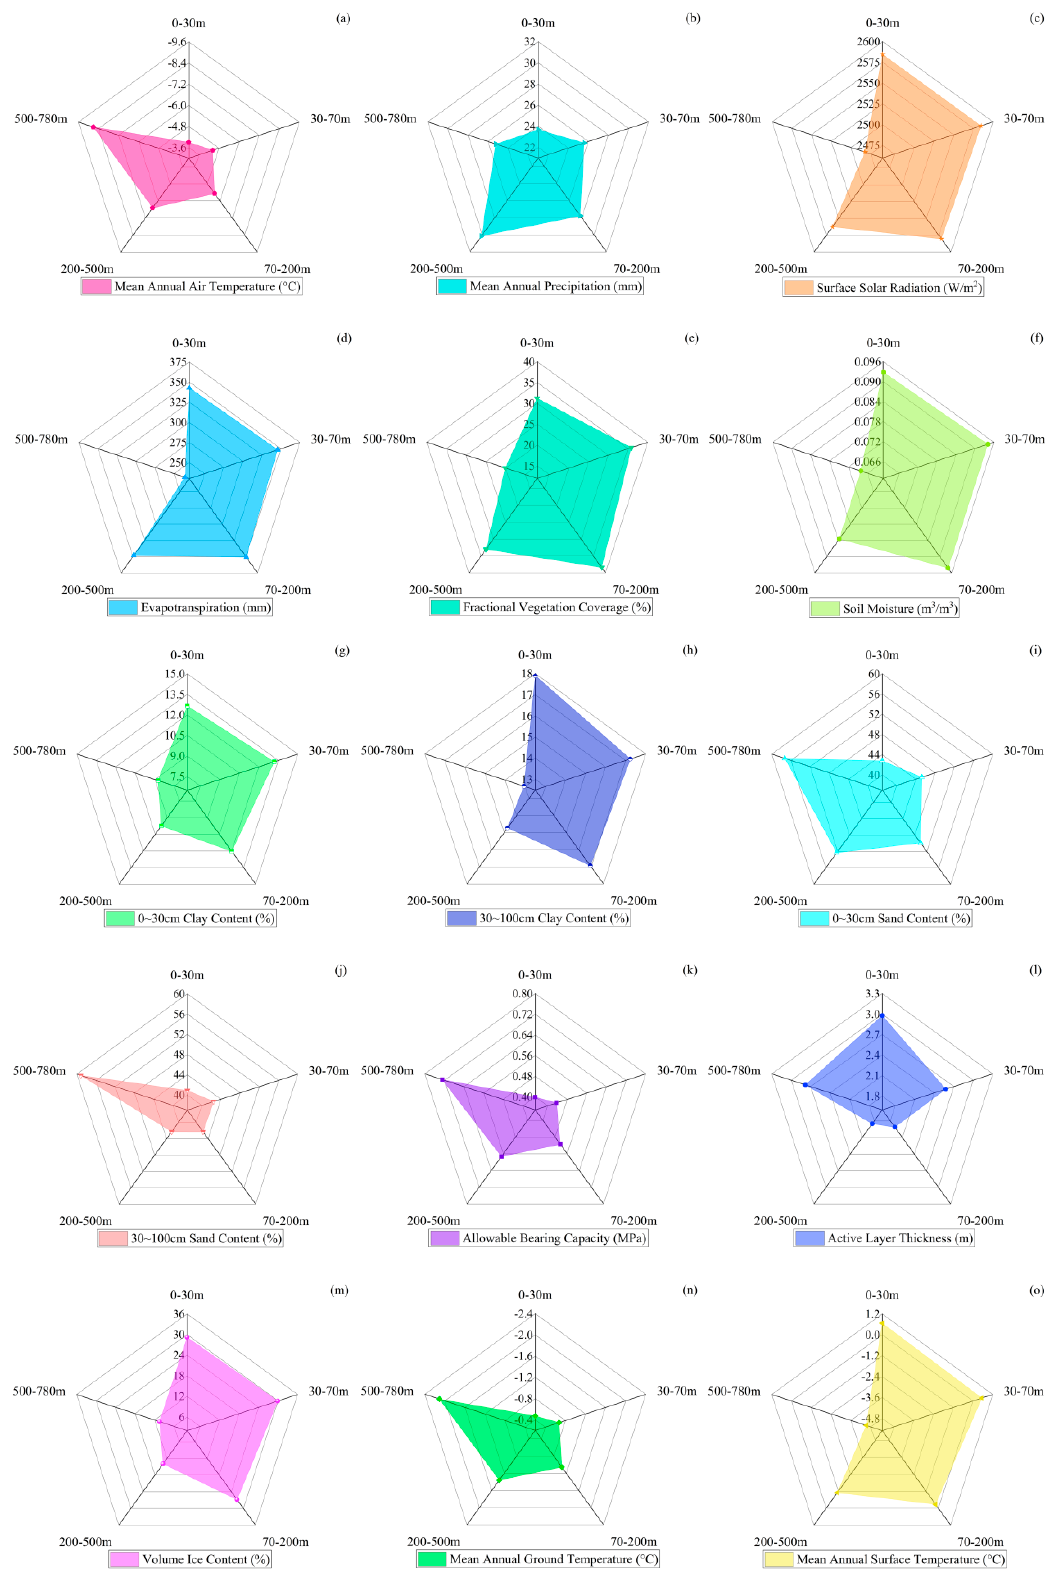
Figure 8. Changes in risk factors considering RDLS: ( a ) MAAT; ( b ) MAP; ( c ) SR; ( d ) ET; ( e ) FVC; ( f ) SM; ( g ) CC1; ( h ) CC2; ( i ) SC1; ( j ) SC2; ( k ) ABC; ( l ) ALT; ( m ) VIC; ( n ) MAGT; ( o ) MAST.